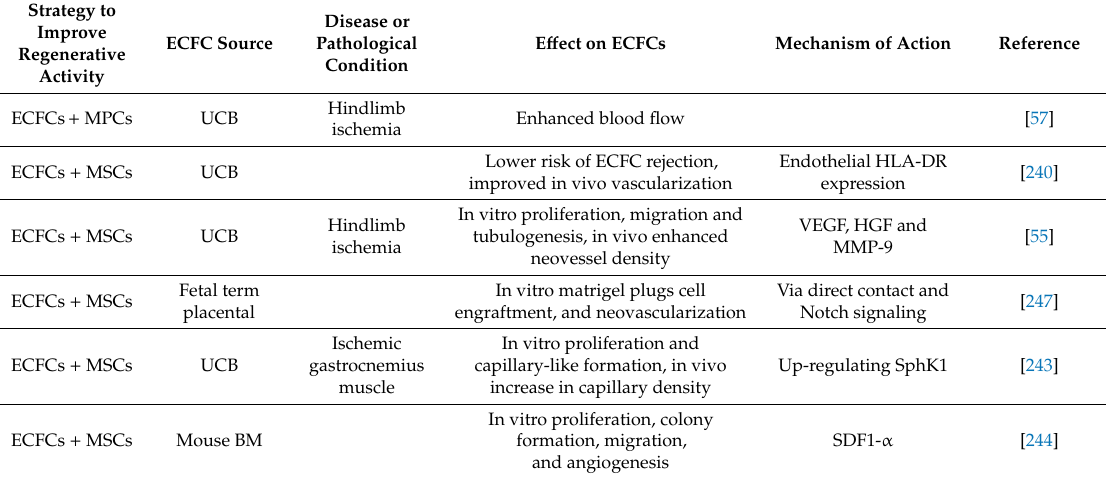
Table 7. Priming ECFCs with mesenchymal progenitor cells (MPCs) and mesenchymal stem cells (MSCs). Strategy to